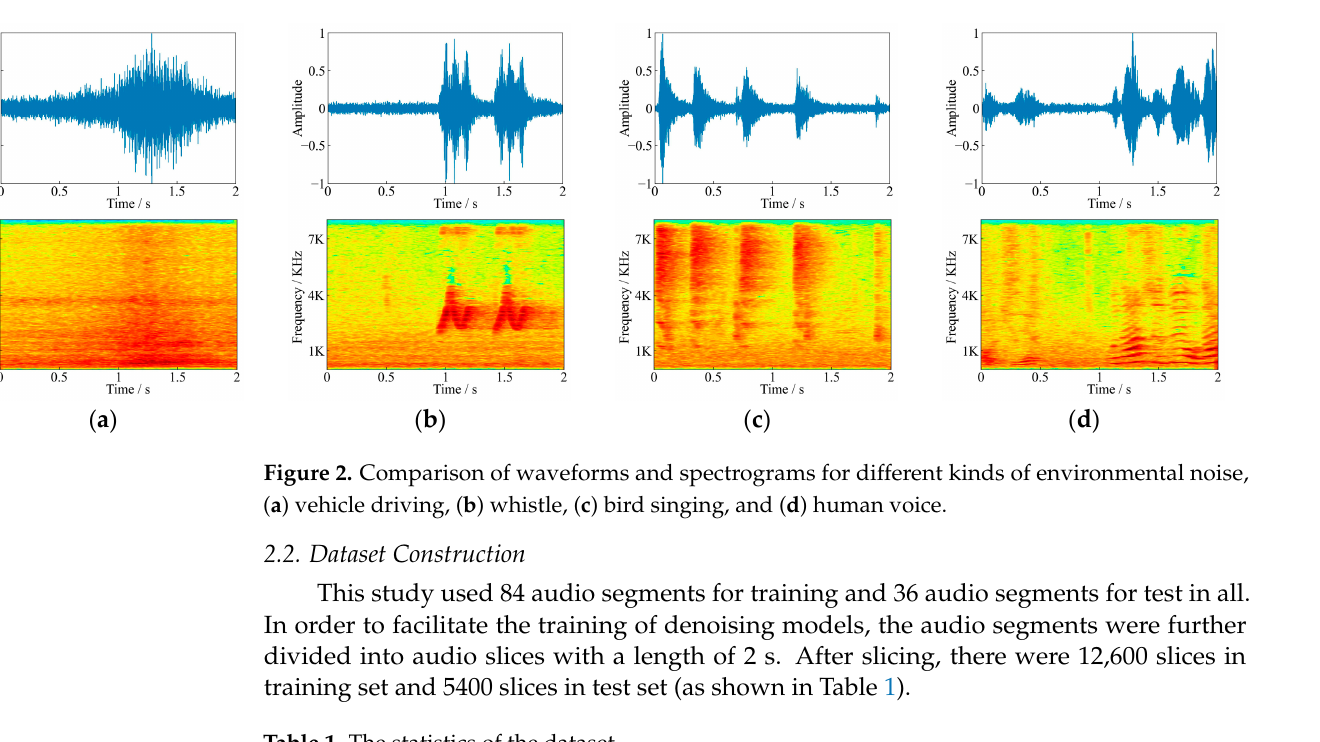
Table 1. The statistics of the